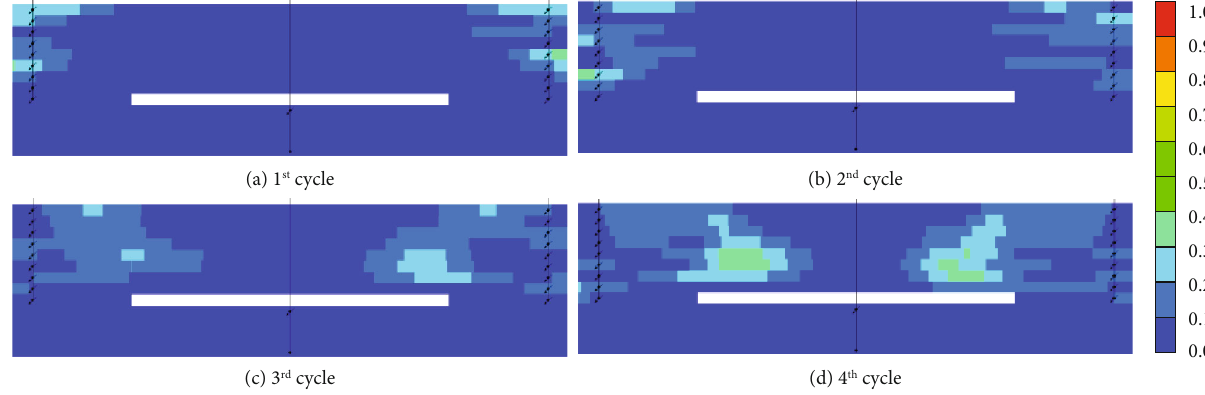
Figure 15: Solvent mole fraction in oil of di ff erent cycles.